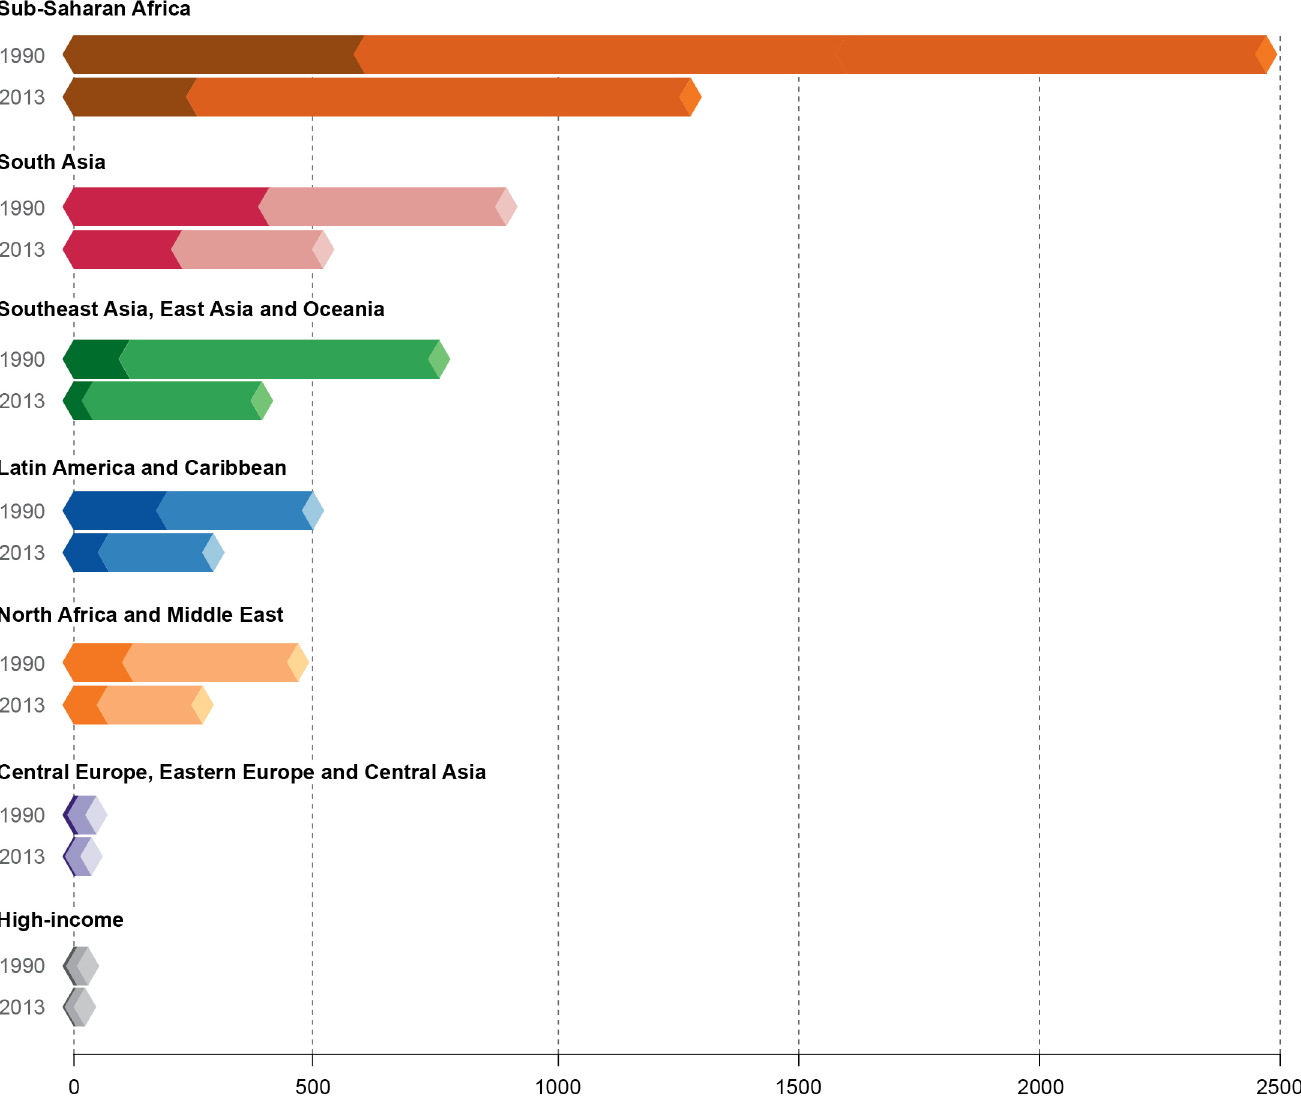
Fig 7. Proportional representation of disability-adjusted life years (DALYs) (per 100,000population) from all NTDs combined in 1990 and 2013 by Global Burden of Disease Study (GBD) super region. Each bar represents the total disability-adjustedlife years (DALYs) per 100,000population for WHO-prioritized NTDs combinedby GBD super region, broken down by percentageof years of life lost (YLLs) (darker shading) and years lived with disability(YLDs) (lighter shading).GBD-estimated numbers for DALY, YLL, and YLD rates for each super regionin 1990 and 2013 are shown in the